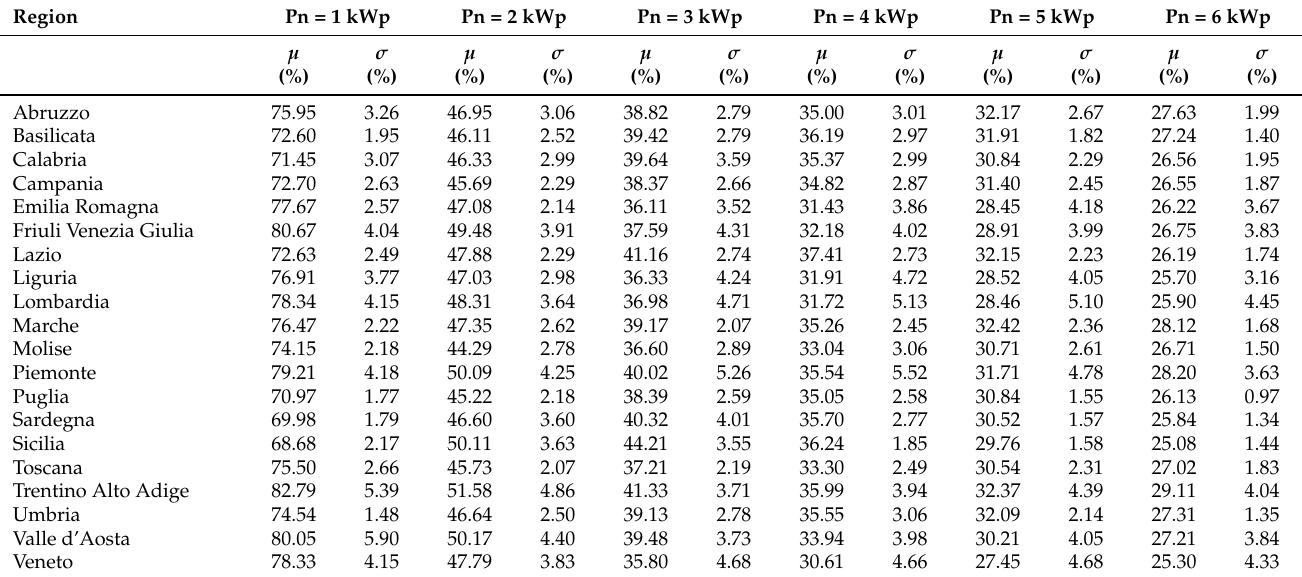
Table 12. Self-Consumption for E L = 2700 kWh with battery.